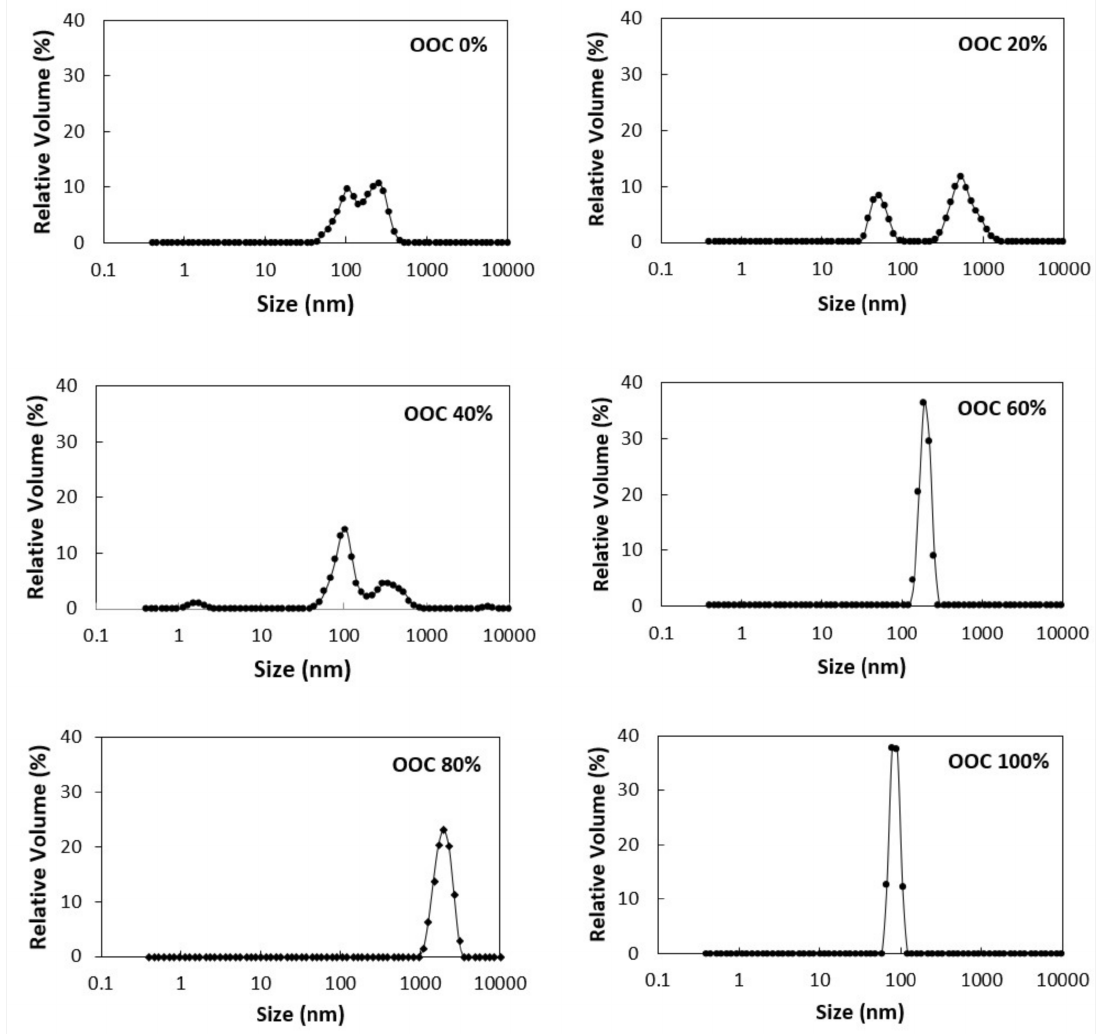
Figure 1. Particle size distribution of aqueous phases containing 1% ( w/w ) OOC extracts.